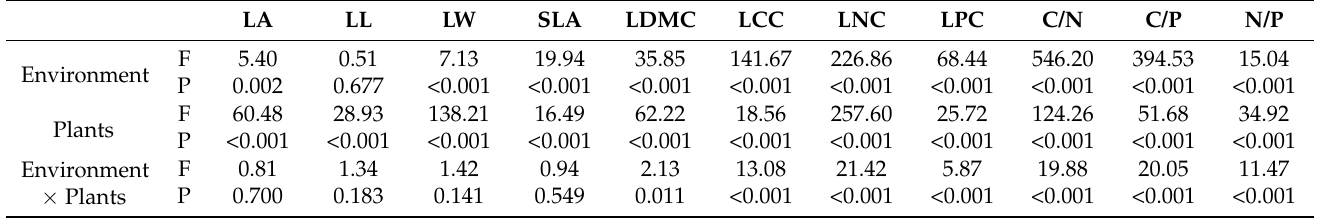
Table 3. Effects of the urban green space environment, plants, and interaction on leaf functional